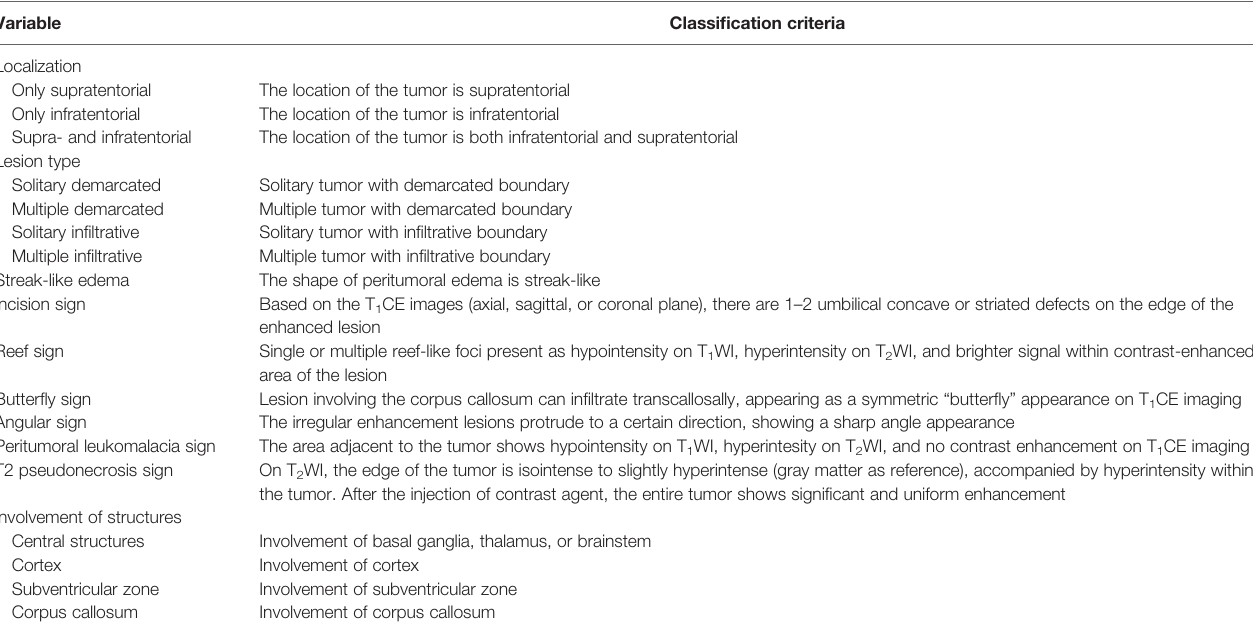
TABLE 1 | MRI morphological feature de fi